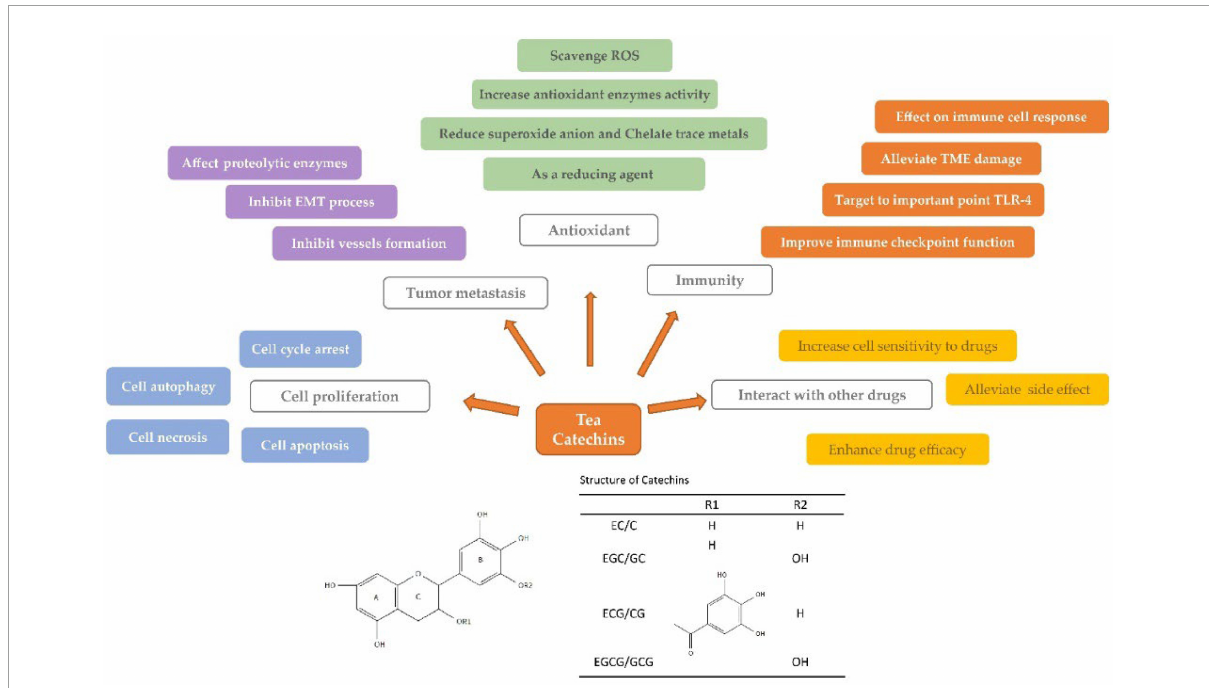
FIGURE6 Anticarcinogenic mechanism of tea catechins. Tea catechins exert their anticarcinogenic effects by inhibiting cell proliferation (blue module), preventing tumor metastasis (purple module), reducing oxidative damage (green module), improving immune activity (orange module), and ameliorating the potency of anticancer drugs (yellow module). Different colored textboxes indicate the specific ways in which tea catechins